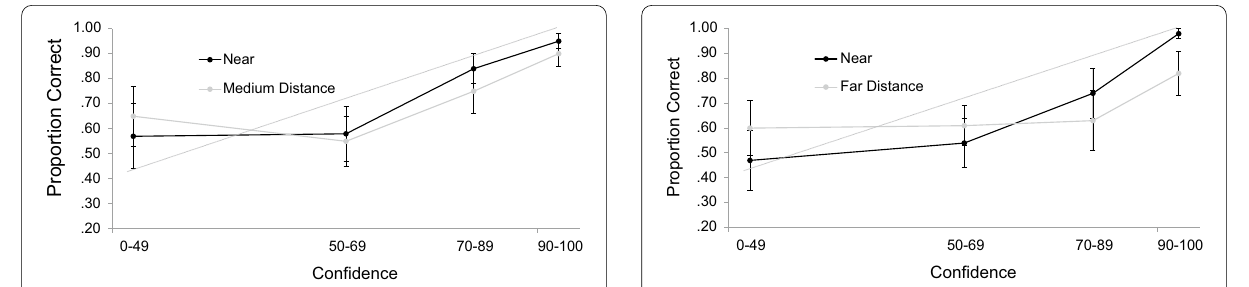
Fig. 2 Calibration Curves for Faces that were Presented at a Near or Simulated Medium Distance in Experiment 1a Note: The diagonal line indicates optimal calibration. Bars represent descriptive 95% confidence intervals